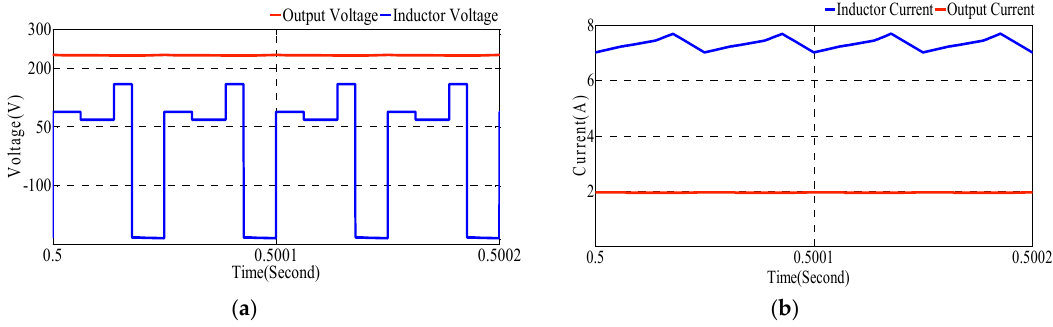
Figure 8. Simulation waveforms of the MBDC converter in buck-boost operation when the duty ratio